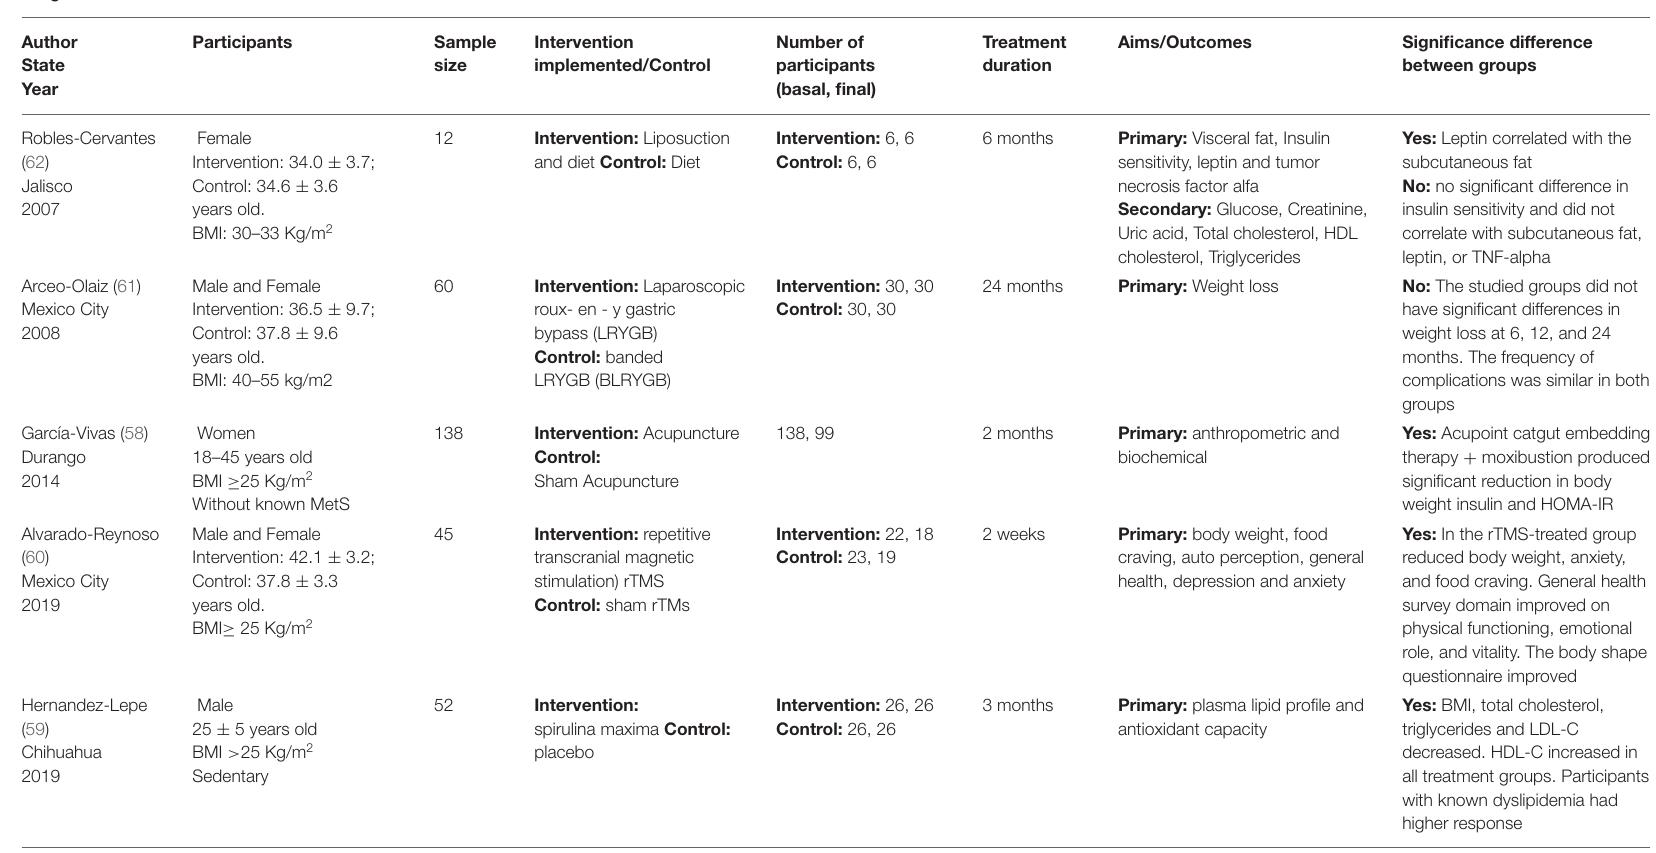
TABLE 4 | Descriptive characteristics and assessment of medications. Surgical and alternative